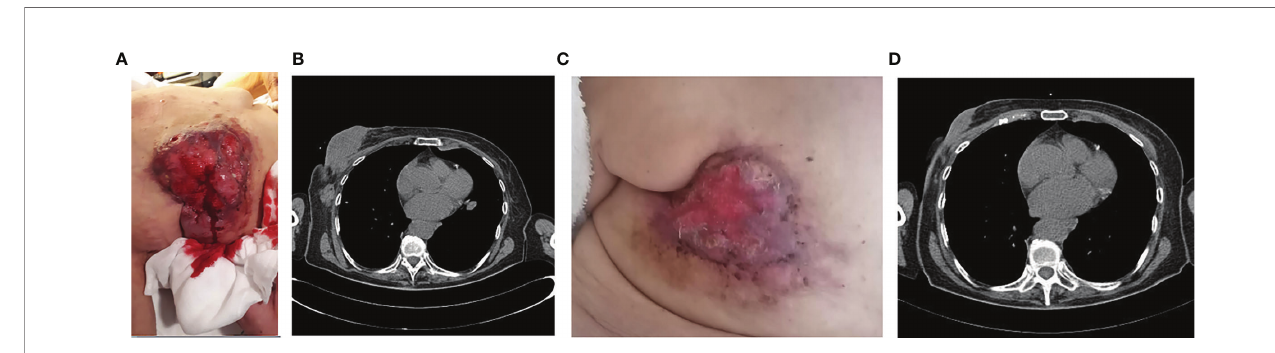
FIGURE 3 | Clinico-radiological presentation of solid, cancer mass of the breast at the diagnosis (A, B) , and after 5 months of treatment (C, D) .